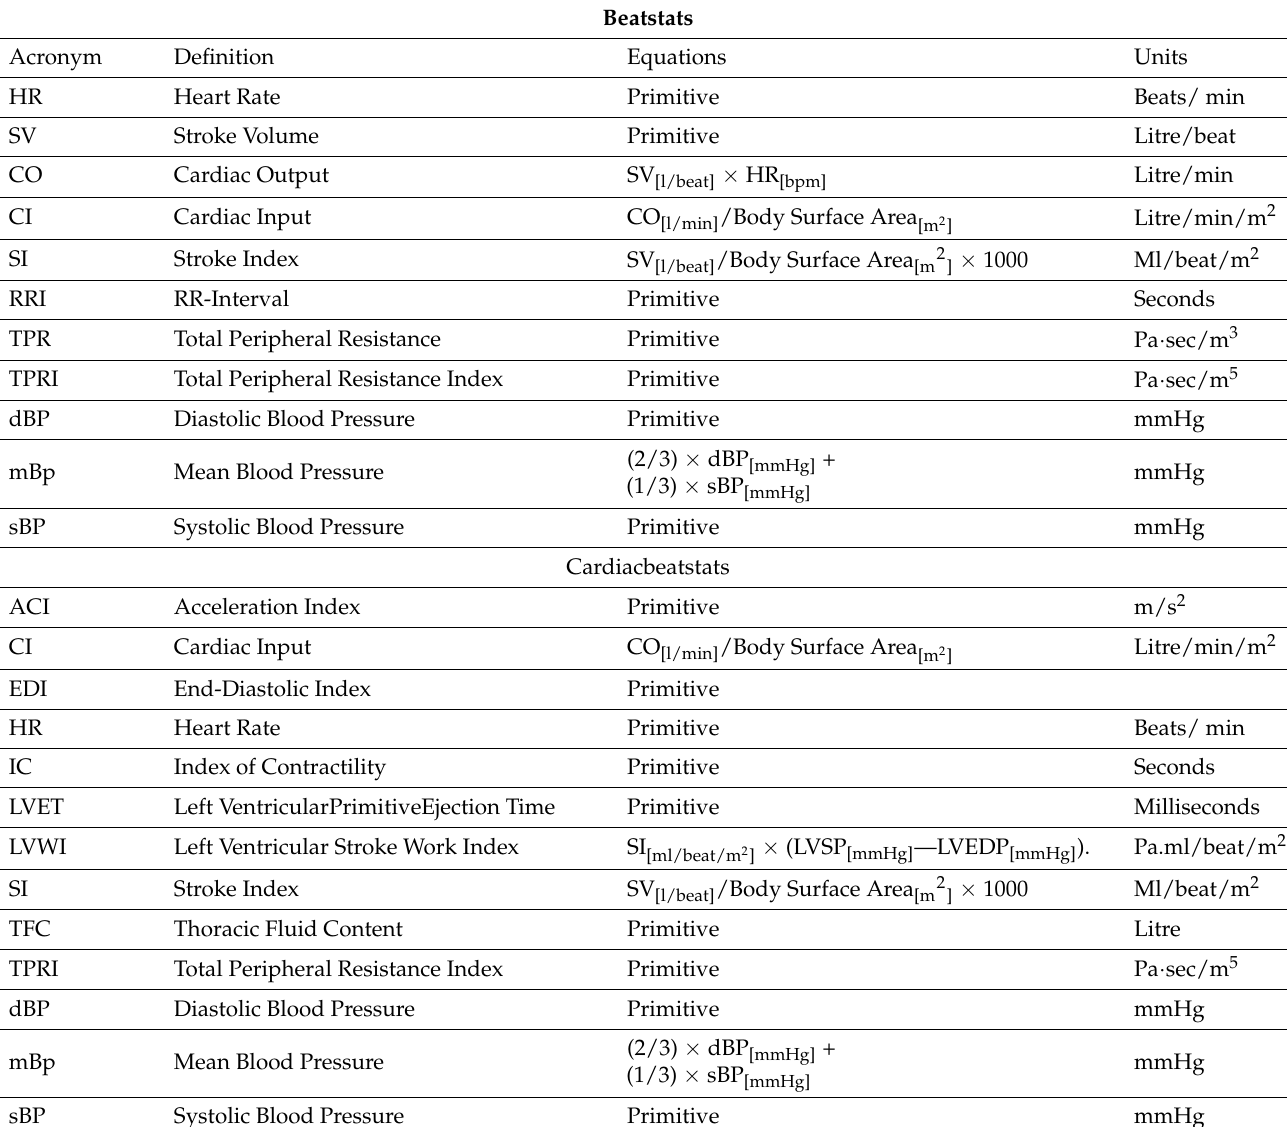
Table 2. Physiological Indicators of Patients Collected Using HUT